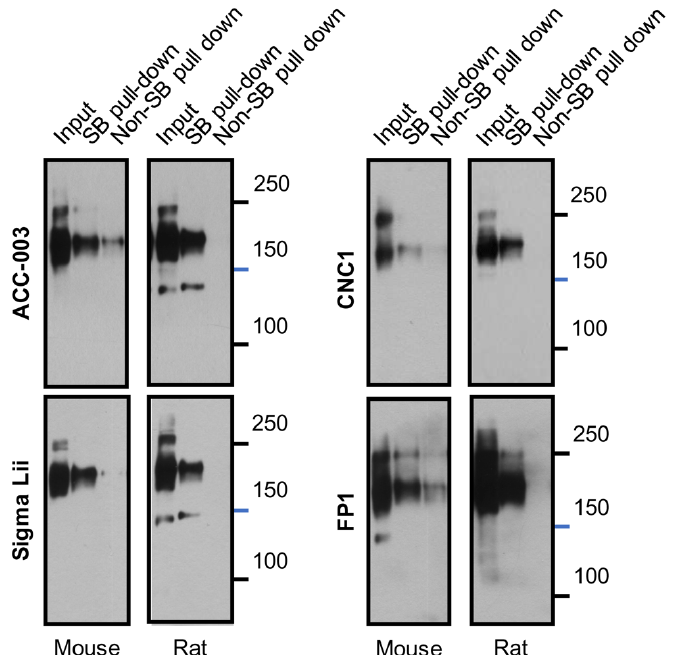
Figure 10. Differential Recognition of a 150 kDa Band in Surface Biotinylated Rat and Mouse Cortical Slices. Acute cortical slices were surface biotinylated and solubilized before pull down with NeutrAvidin Sepharose, SDS-PAGE in 8% acrylamide gels, and immunoblotting with CNC1, FP1, ACC-003, and Sigma Lii. Control reflects slices mock treated without Sulfo-NHS-SS-biotin to demonstrate specificity of pulldown. Twenty μL lysate was also directly loaded for